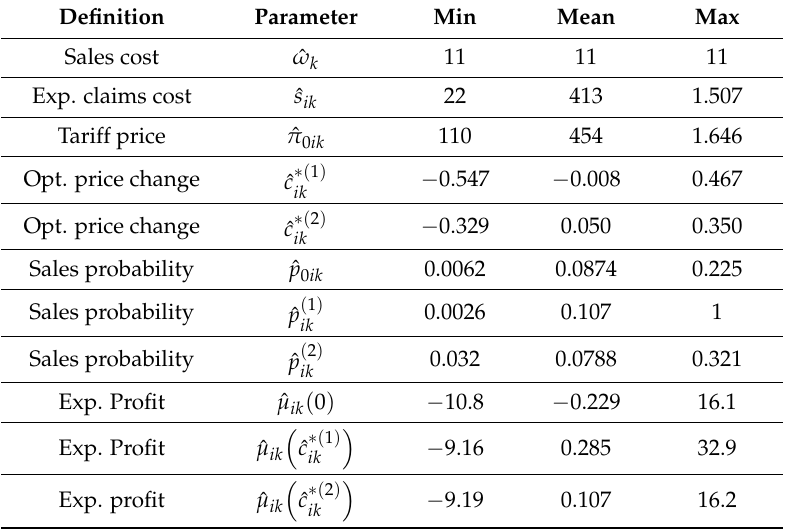
Table 3. Summary statistics of the parameter estimates, optimal price changes and corresponding expected profit. Min and max are the value (lowest and highest) of a single observation of the corresponding magnitude in the first column.